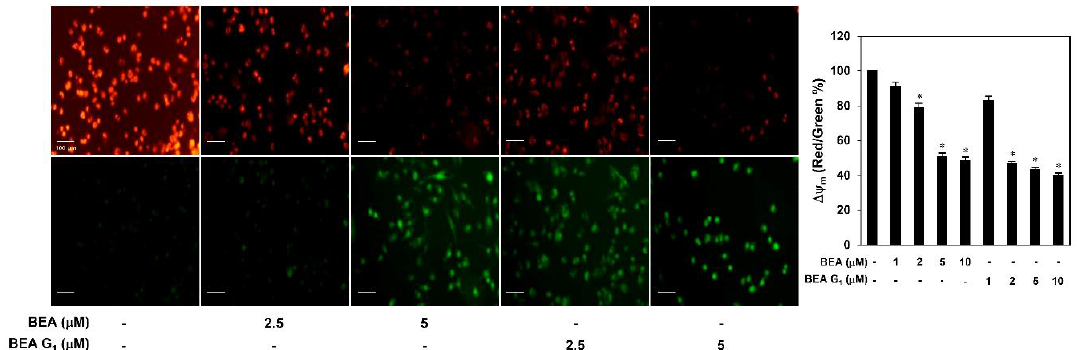
Figure 6. E ff ects of BEA and BEA G 1 on MMP in A375SM melanoma cells. The cells were treated with BEA and BEA G 1 (2.5 and 5 µ M) for 24 h and stained with JC-1. The fluorescent images were obtained under a fluorescence microscope, and fluorescence intensity was detected using a multimode microplate reader. Scale bar, 100 µ m. * = p < 0.05 versus the control.